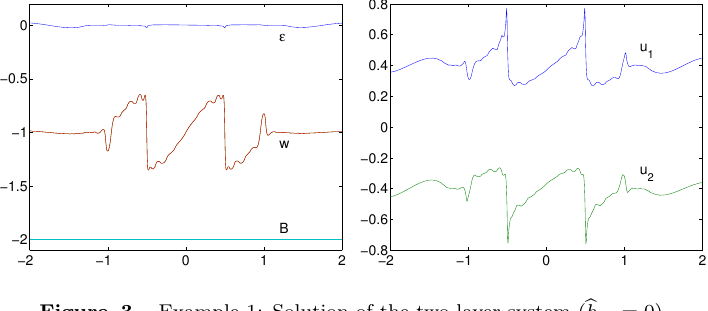
Figure 3. Example 1: Solution of the two-layer system ( (cid:98) h m = 0).